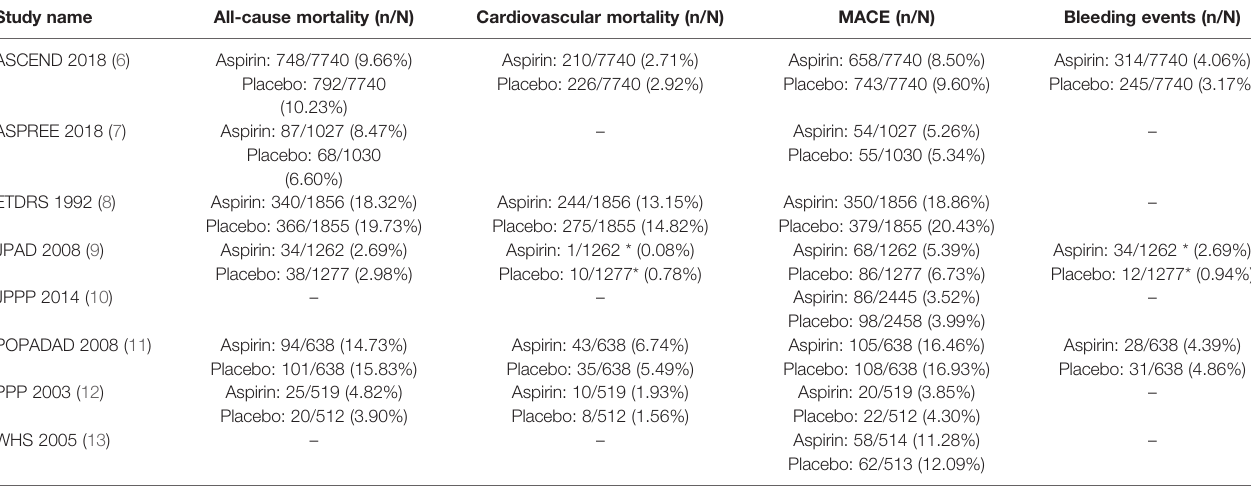
TABLE 2 | Outcomes of all-cause mortality, cardiovascular mortality, composite outcome of major adverse cardiovascular events (MACE) and bleeding events in the included studies.